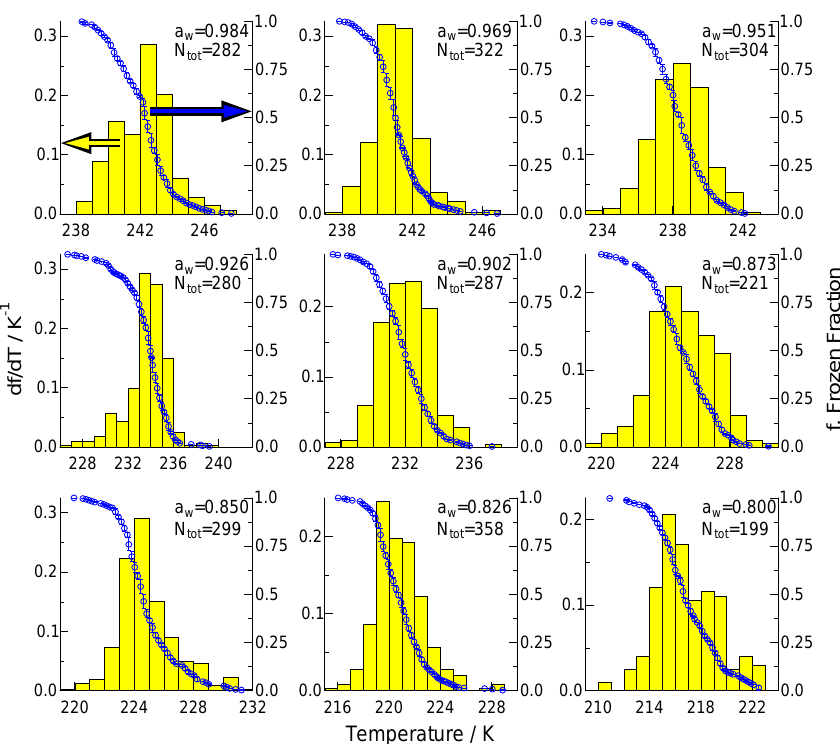
Fig. 7. Summary of all observed heterogeneous ice nucleation events as a function of a w and T . The frozen fraction, f , of droplets in 0.2K temperature increments is represented by blue circles. Error bars indicate the range of f in a temperature increment of 0.2K. Yellow bars show the probability density histogram (PDH) binned in 1.0K increments. For each panel, a w and the total number of analyzed droplets, N tot , are given. The values for the PDH are given on the left y -axis and f on the right y